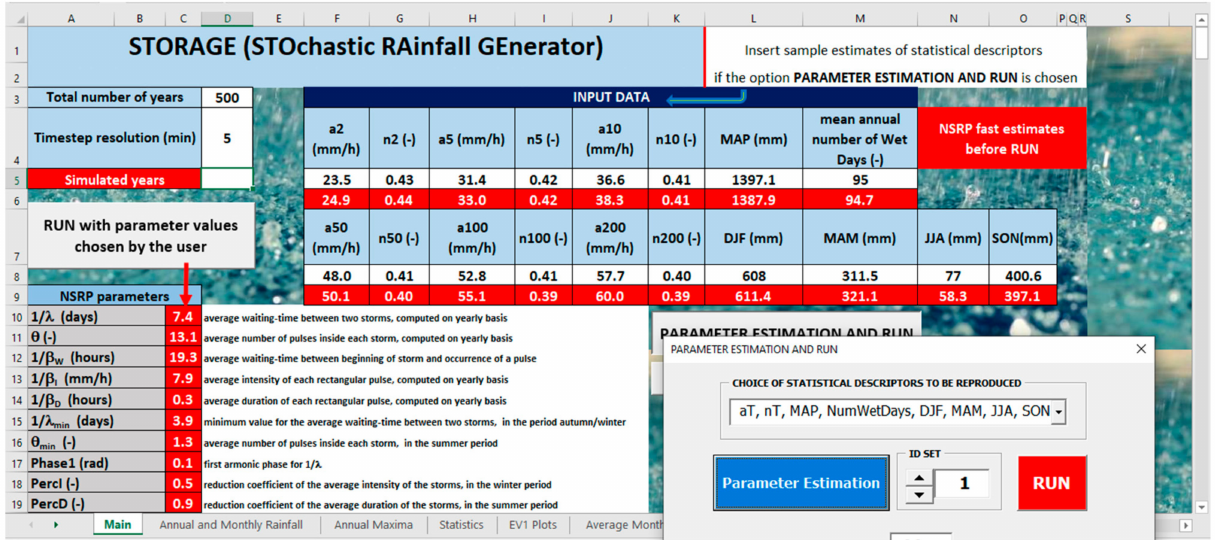
Figure 6. Example of procedure for calibration, by using the combobox at the top of the userform.